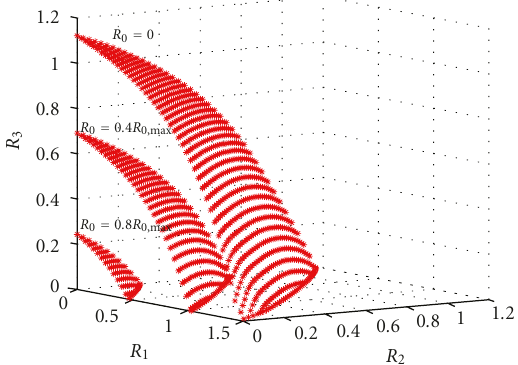
Figure 3: The SPCGS rate regions obtained via signomial program- ming for R 0 = 0, R 0 = 0 . 4 R 0,max and R 0 = 0 . 8 R 0,max .